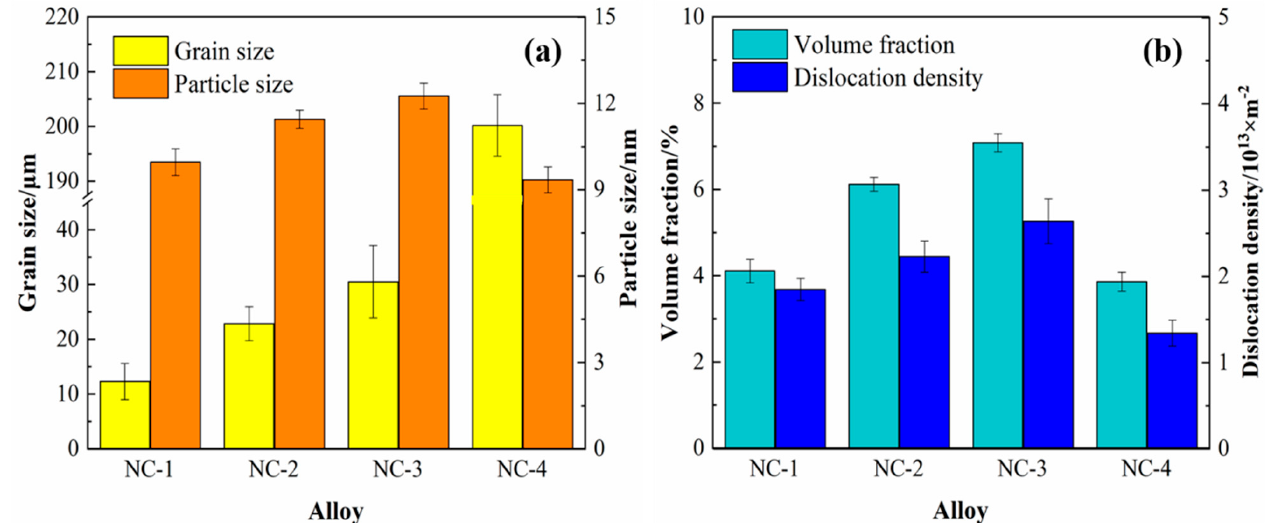
Figure 7. Statistics of grains and precipitates of the tested alloys at the peak aging state. ( a ) the size of grains and precipitates; ( b ) the volume fraction and dislocation density.